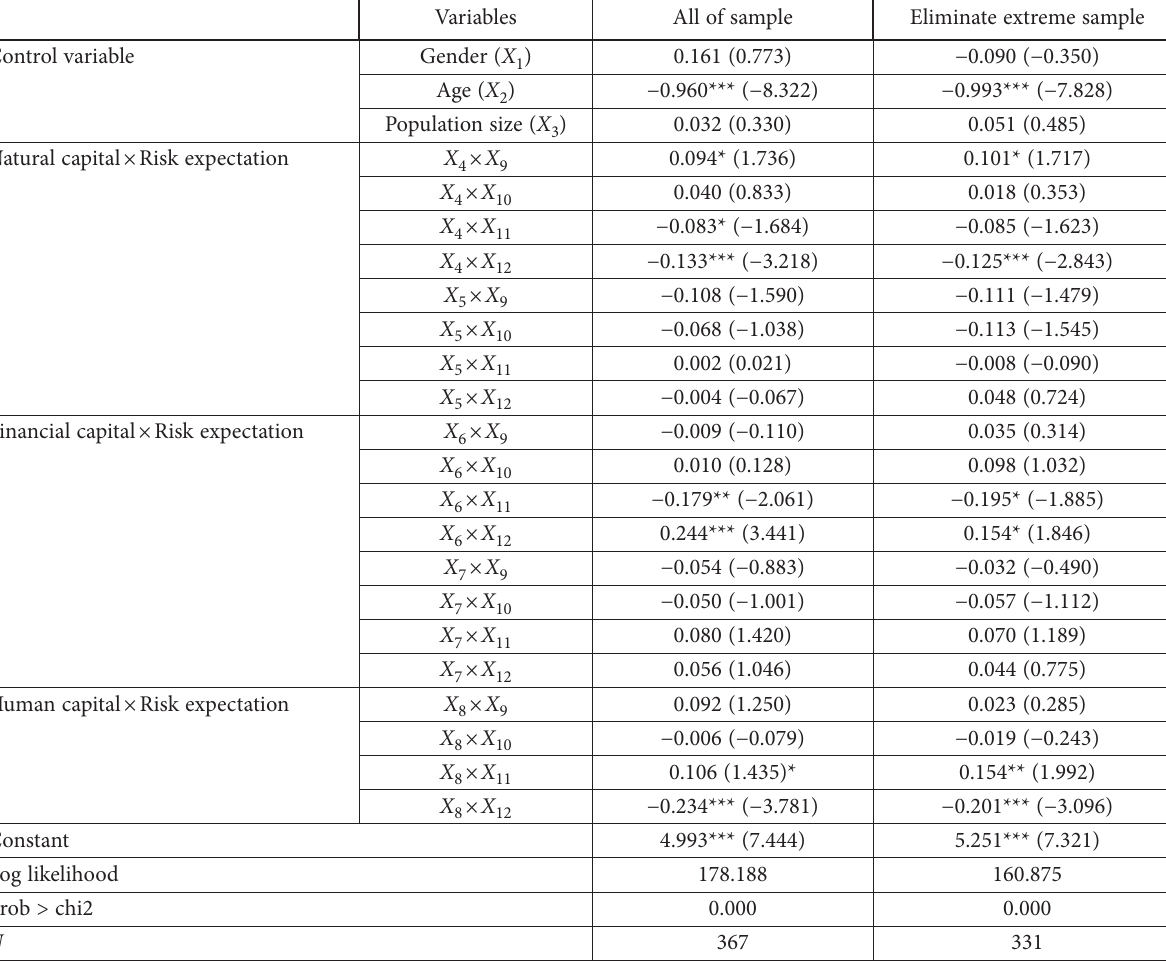
Table 8. Results of the interaction model for the pooled